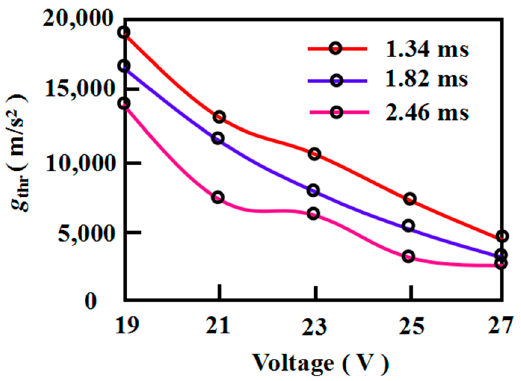
Figure 16. Correspondence between acceleration and voltage in the pull ‐ in effect.